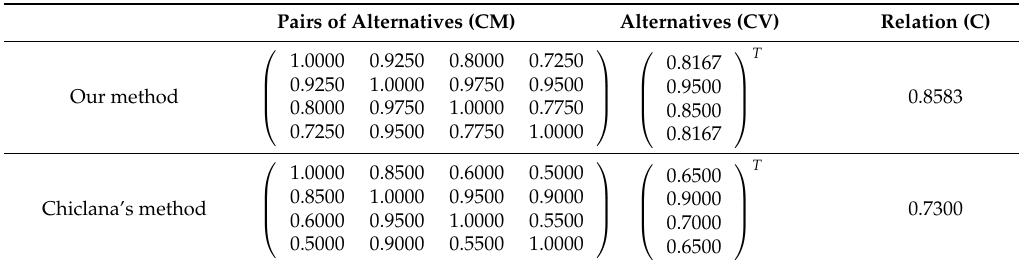
Table 1. The Consistency Measures of the Preference